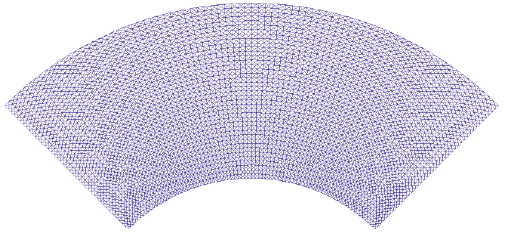
Figure 1: The domain with computational grid.